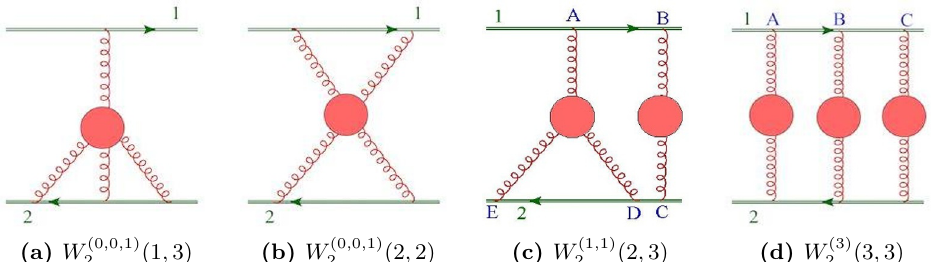
Figure 6. Representative skeleton diagrams for the four non-vanishing Cwebs in a massless theory connecting two Wilson lines, and whose perturbative expansion starts at O ( g 6 ). Cwebs (a) and (b) have a single skeleton diagram, while Cwebs (c) and (d) have six.